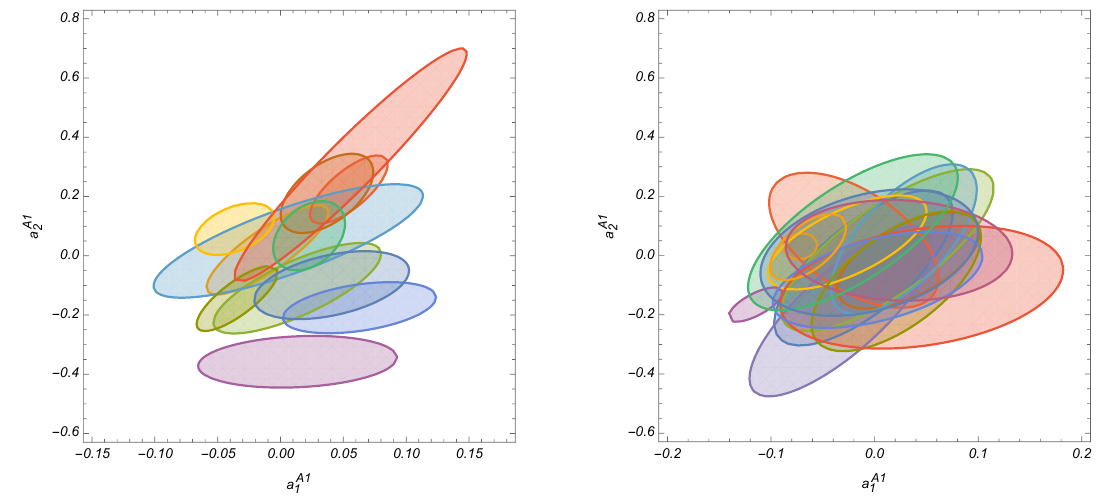
Figure 2 . Ellipses from sample replicas in the ( a A 1